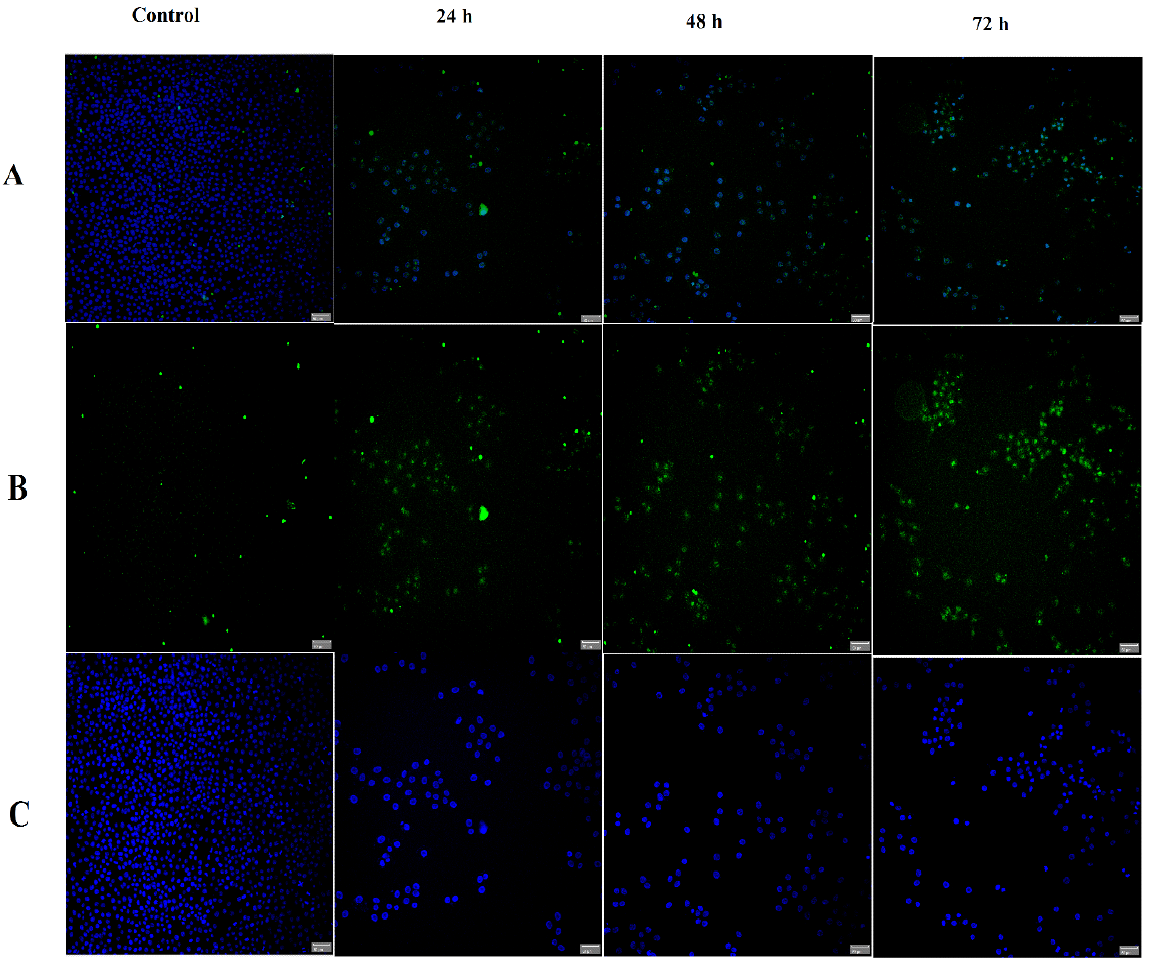
Figure 12. Immunofluorescent detection of Bax in MCF7 cells. The experiment was performed twice for this protein. Data revealed an increase in the level of Bax protein after treatment. ( A ) Composite image of FITC with DAPI, ( B ) FITC conjugated with Bax and ( C )